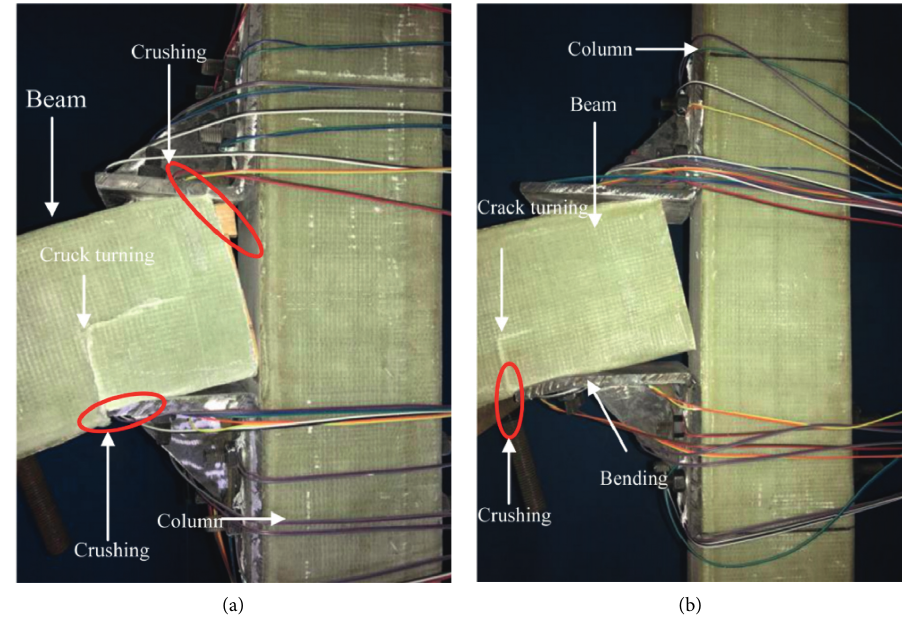
Figure 8: Local crushing failure of the GFRP-wood composite sandwich beam. (a) TJ-110-R. (b)